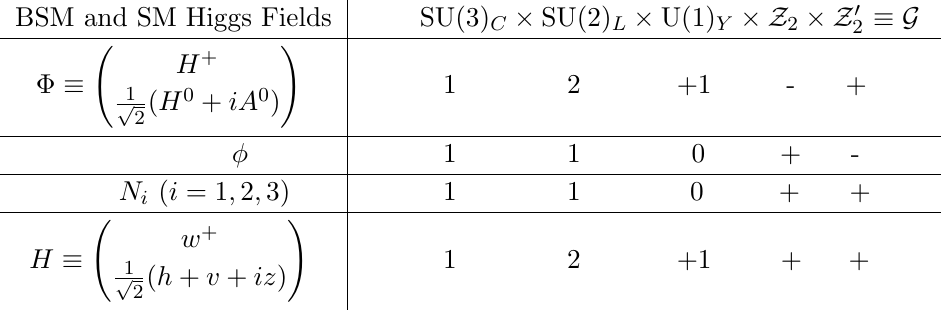
Table 1 . Charge assignments of the BSM (cid:12)elds assumed in the model under G as well as that of SM Higgs. The U(1) Y hypercharge is chosen as Q = T 3 + Y=